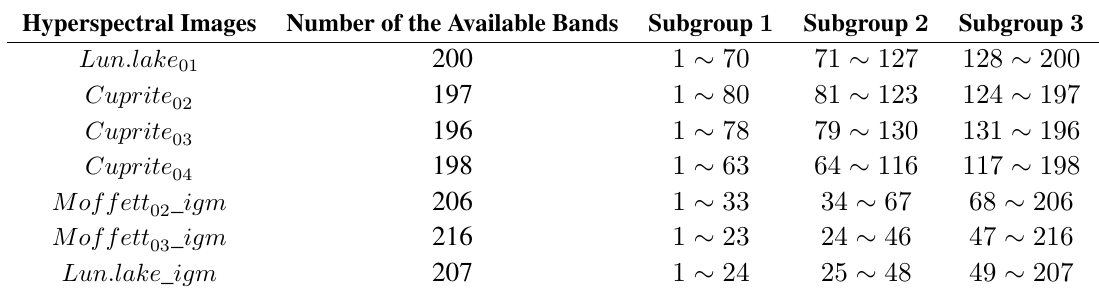
Table 3. Number of the available bands after preprocessing and the partitioning results. Hyperspectral